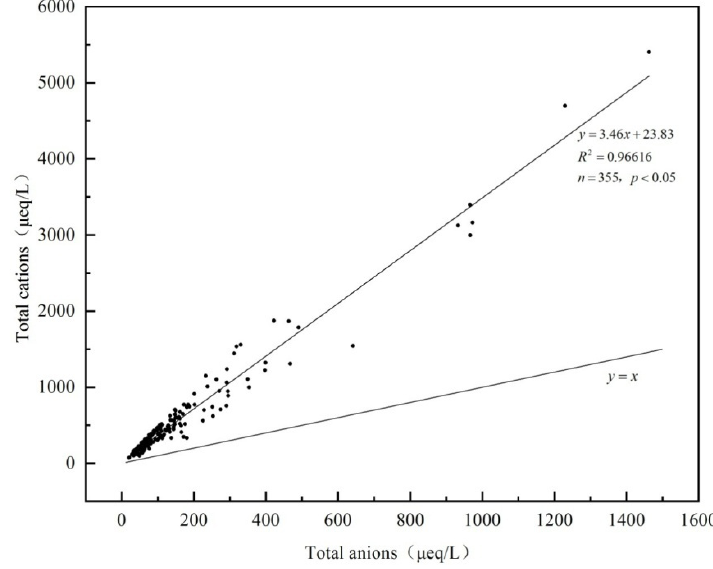
Figure 2. Scatter plot of total anions versus total cations.